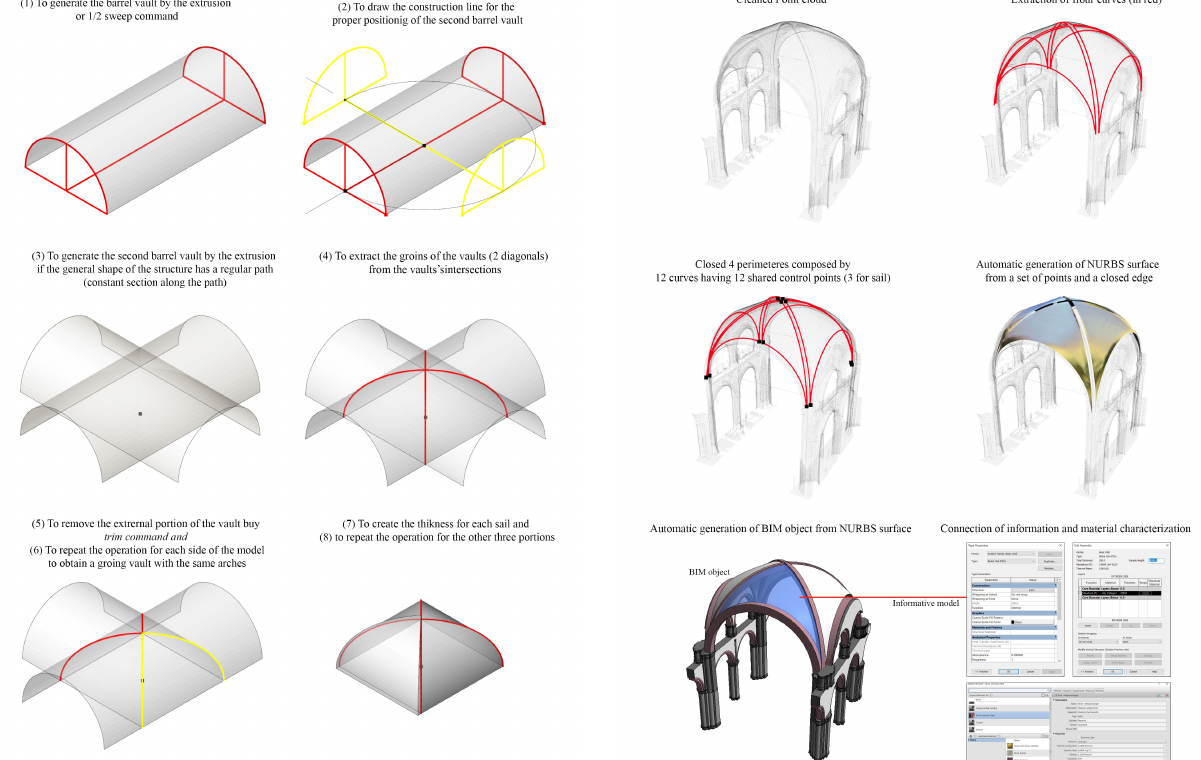
Figure 14. The traditional process: how to model a groin vault. Figure 15. The research method: how to model a groin vault by GOG 10. It improves the generative process, simplifying the modelling for beginners and BIM experts at the same